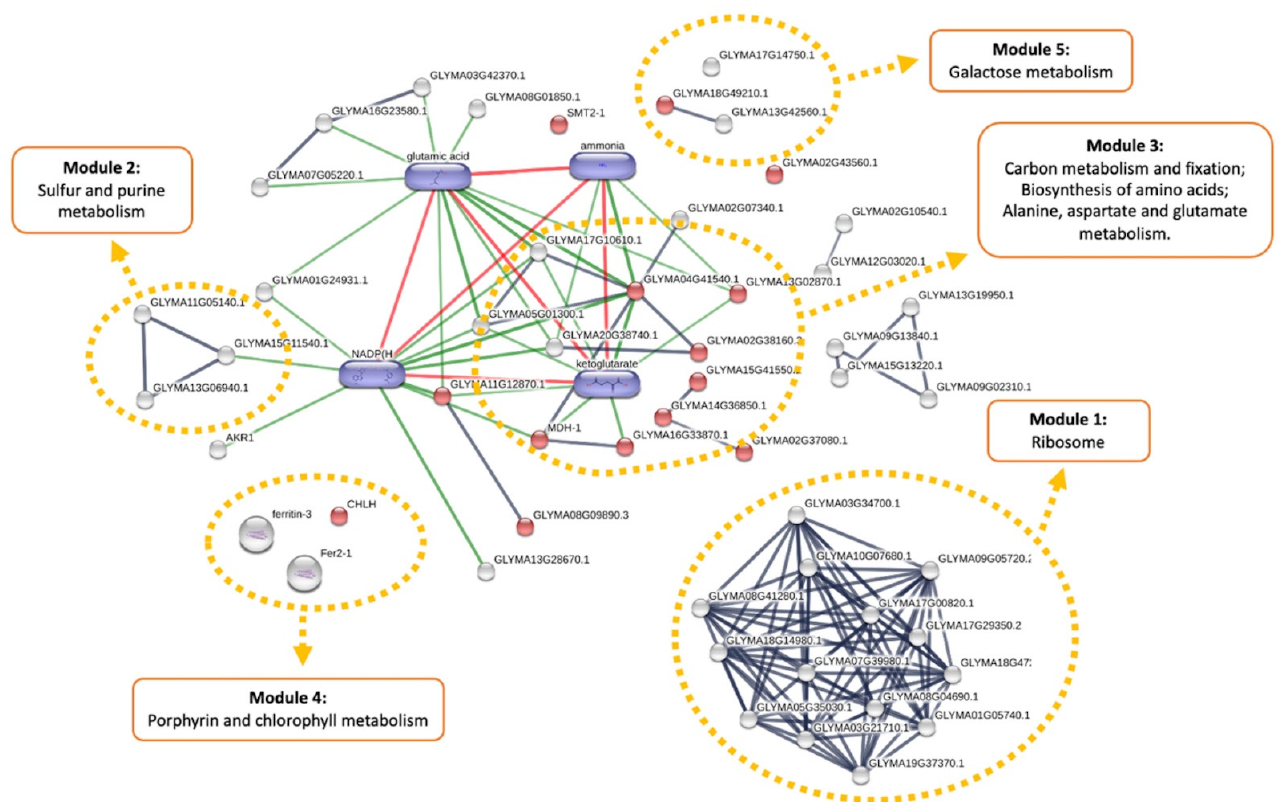
Figure 7. Biological network of differentially expressed proteins in response to accumulated effects of genetic transformation, herbicide and drought stress in soybean plants. The visual network was built using Stitch database. Functional modules are highlighted in orange dotted lines. Additional metabolites (purple) were added as functional partners in order to show network context. Stronger associations are represented by thicker lines. Protein–protein interactions are shown in grey, chemical–protein interactions in green and interactions between chemicals in red. Image is automatically retrieved from the Stitch software. No manual entries have been made.